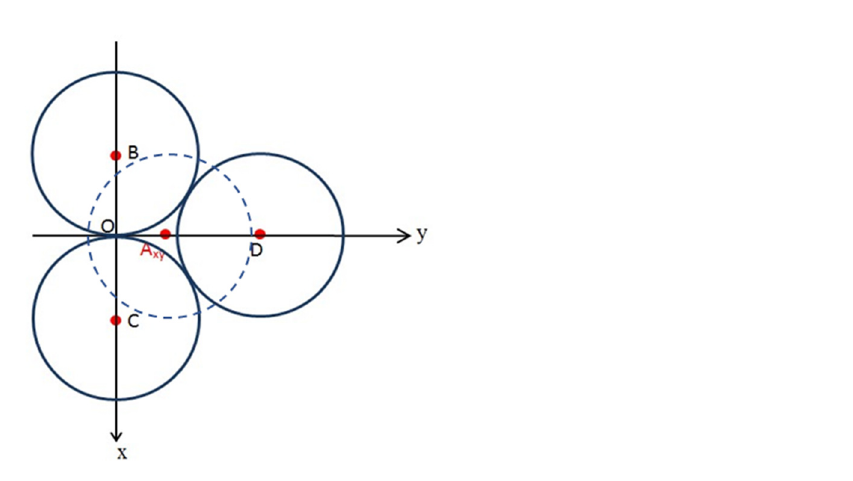
Figure 2. The projection of the steel balls B, C, and D in the lower shear box on the xy plane. The centers of balls A, B, C, and D are shown in red dots. During the test, a constant displacement rate of 0.005 mm/s was applied on the lower shear box, and Ball A would ride over Balls B and C. Based on the geometry and